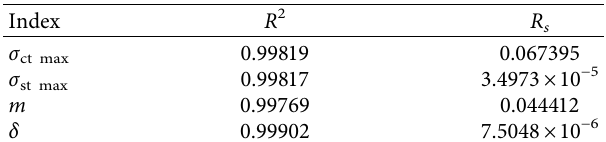
Figure 7: Optimization results. (a) Maximum tensile stress of the steel plate and vertical displacement. (b) Maximum tensile stress of the UHPC layer and mass of the composite bridge deck. Table 3: The values of the coefficient of determination and relative root mean square